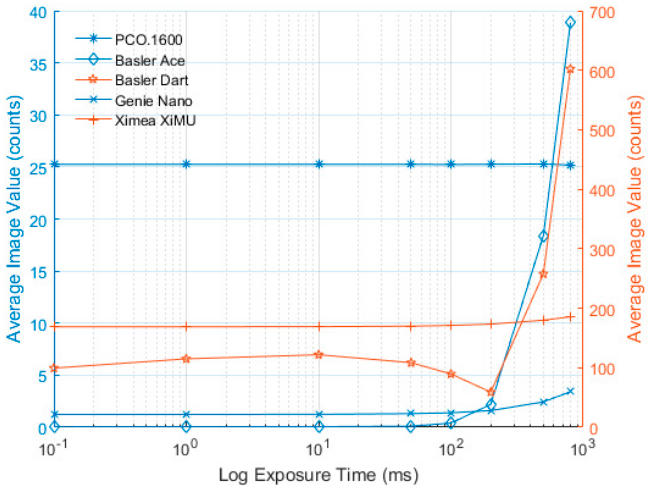
Figure 8. Mean dark exposure value vs. log exposure time for all cameras. PCO.1600, Basler Ace and Genie Nano are plotted against the left y axis and Basler Dart and Ximea XiMU are plotted against the right y axis.